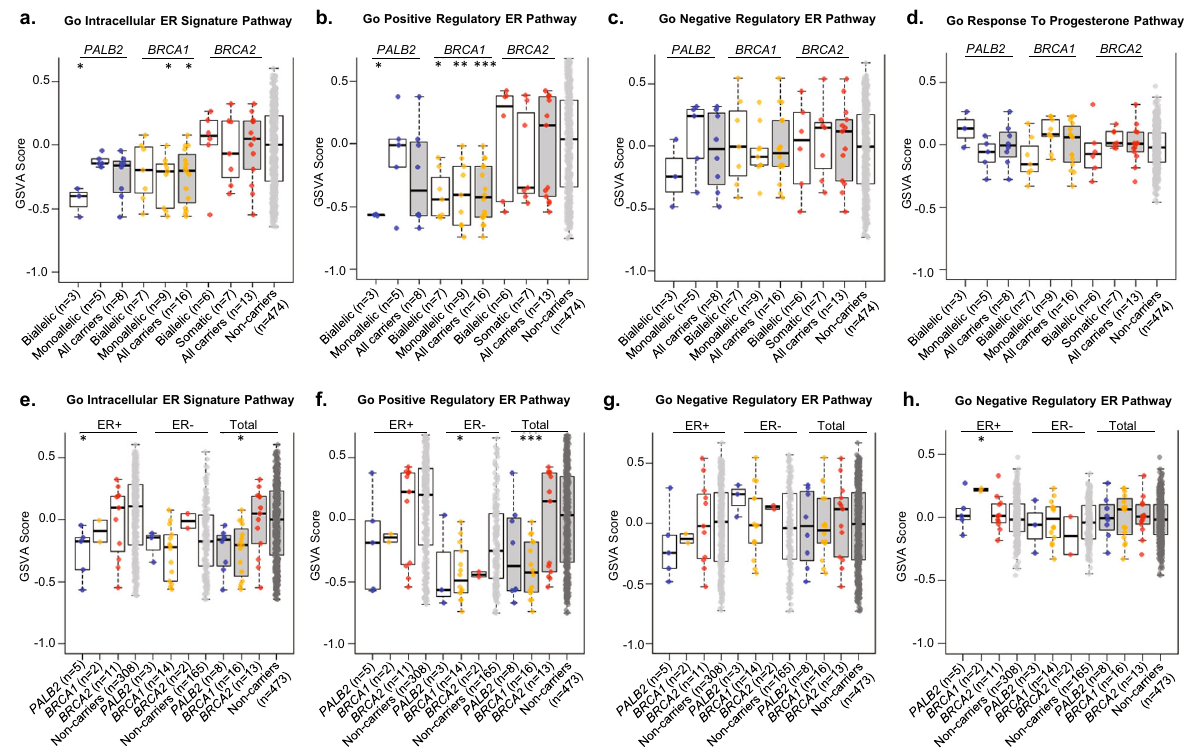
Fig. 2 ER and PR pathway analysis, strati fi ed by allelic status ( a – d ) and hormone status ( e – h ). a GO intracellular ER signature pathway. b GO positive regulatory ER pathway. c GO negative regulatory ER pathway. d GO response to progesterone pathway (only samples with available RNA-seq data were included in this analysis). e GO intracellular ER signature pathway. f GO positive regulatory ER pathway. g GO negative regulatory ER pathway. h GO response to progesterone pathway. Boxplots represent medians (centre line) and interquartile range, and whiskers represent the maximum and minimum values within 1.5 times the interquartile range from the edge of the box. Each data point represents an individual sample. P values: Comparison of each category vs non-carrier. *** p < 0.001; ** p < 0.01; * p < 0.05; Mann – Whitney U test (bootstrap analysis was